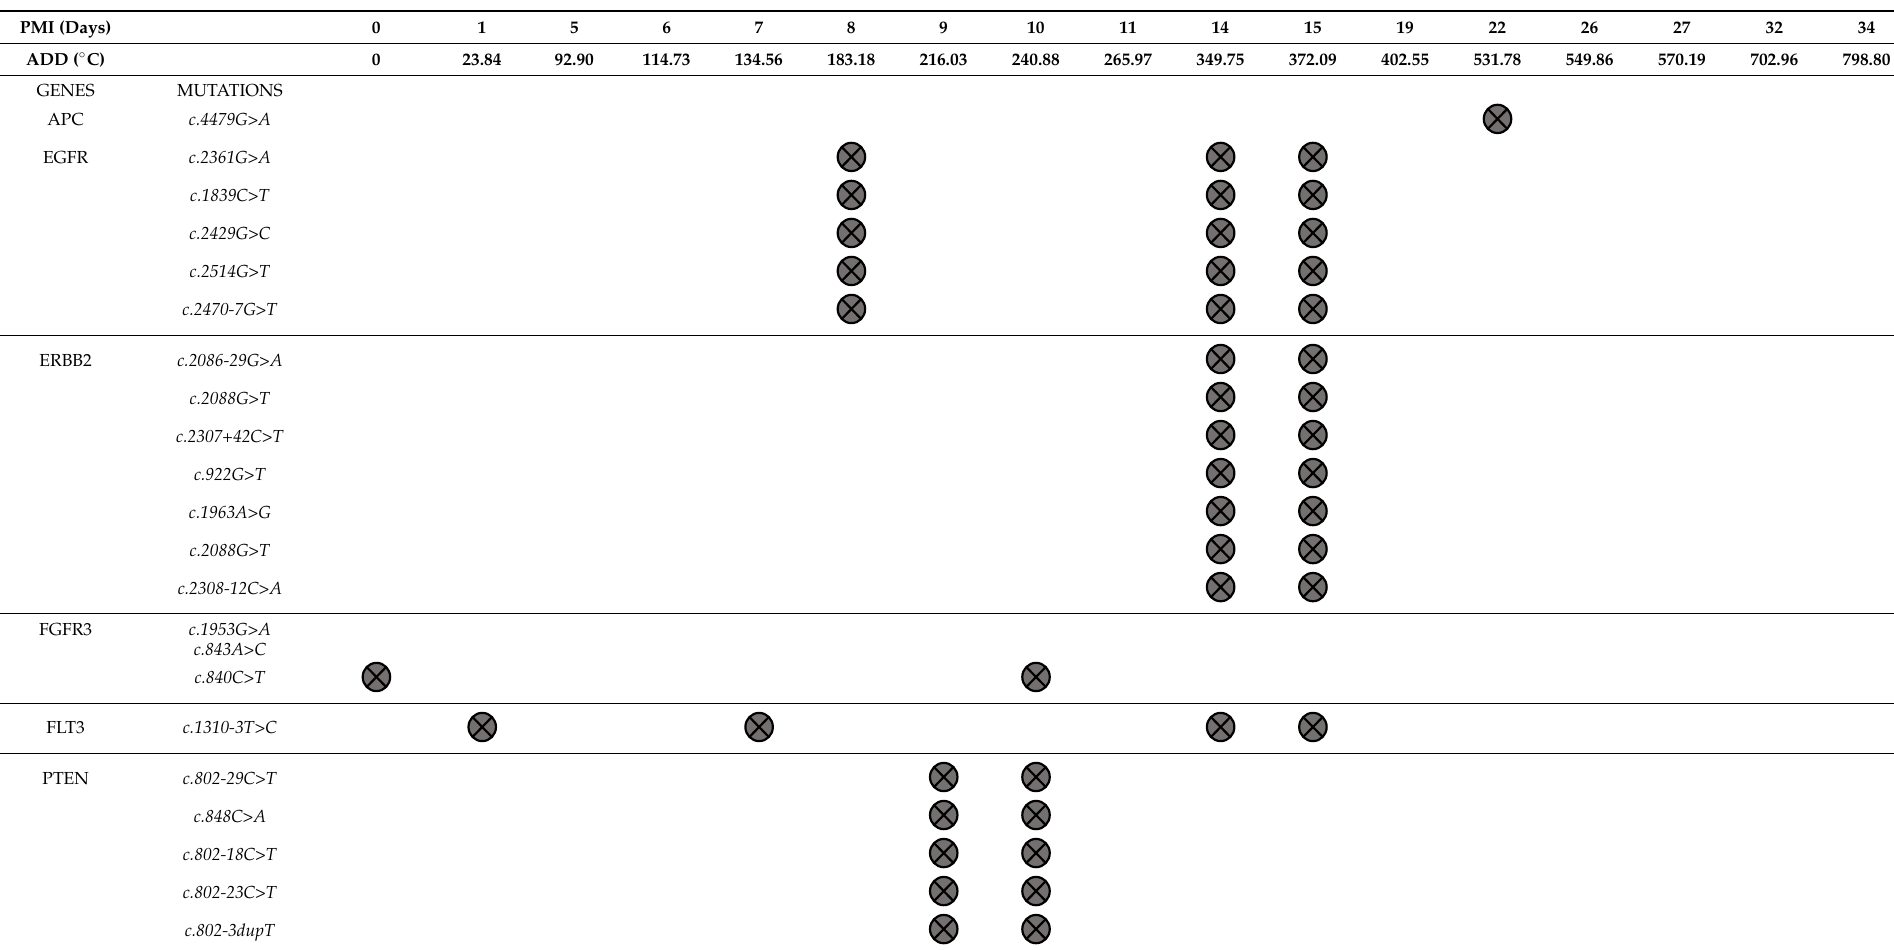
Table 4. Mutations that were not found only for specific